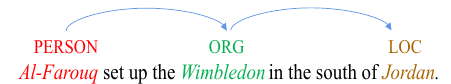
Figure 1. A sample with annotated entity types.